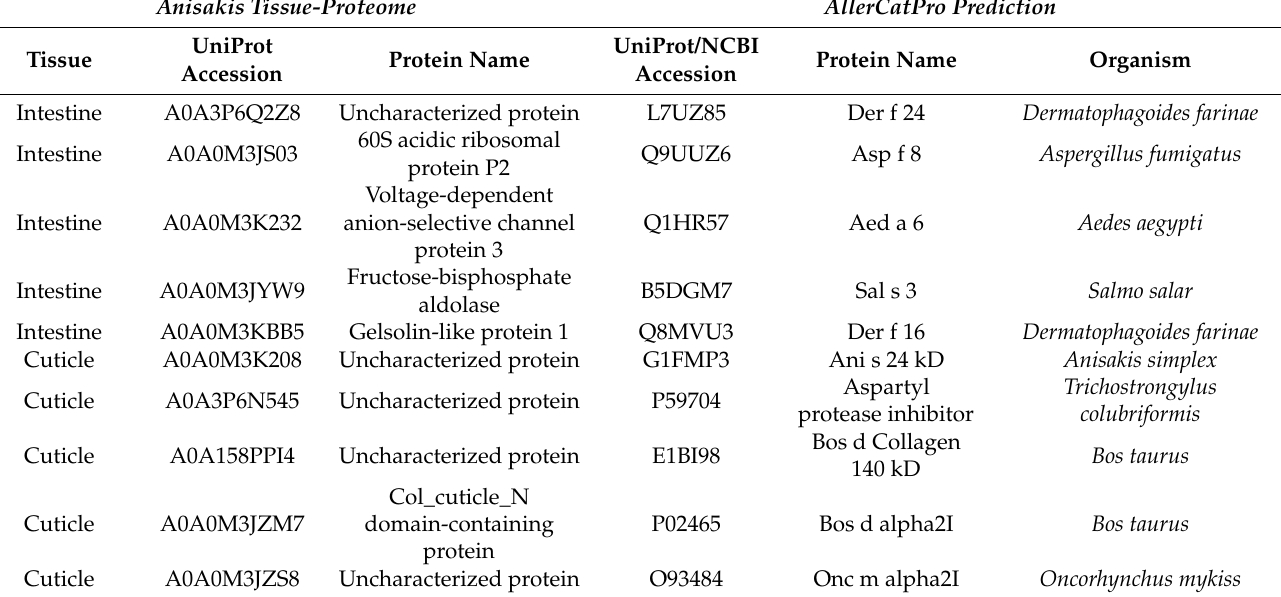
Table 2. Five top strong evidence results of the identification of potential allergens in the tissue- specific proteome of A. simplex s. s. L4 larvae. Detailed annotation of all proteins submitted to the analysis can be found in File